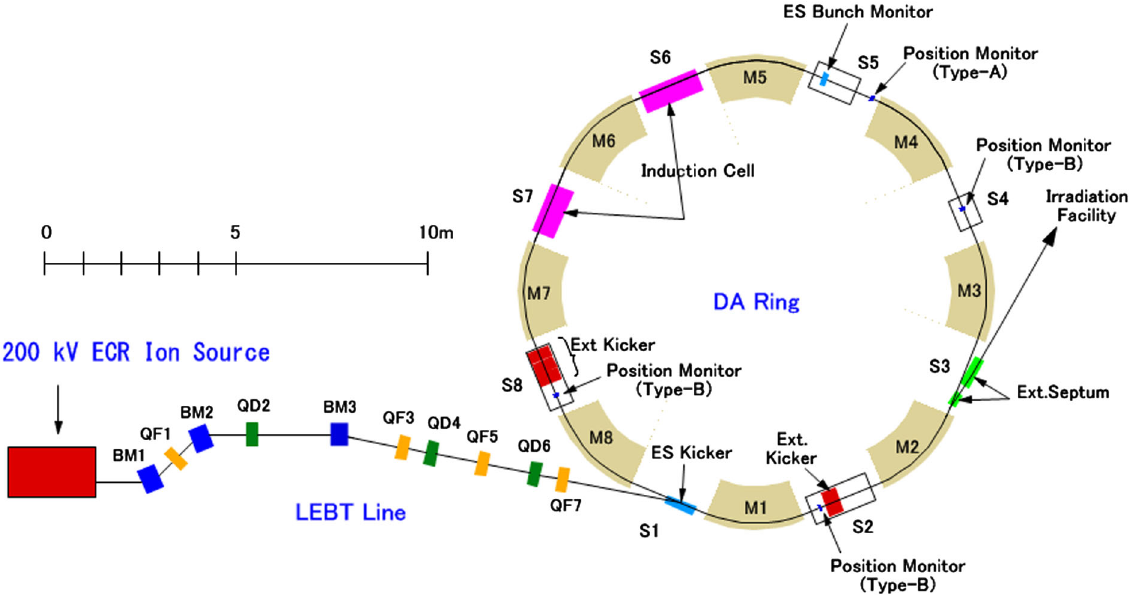
FIG. 1. Schematic view of the KEK-DA.